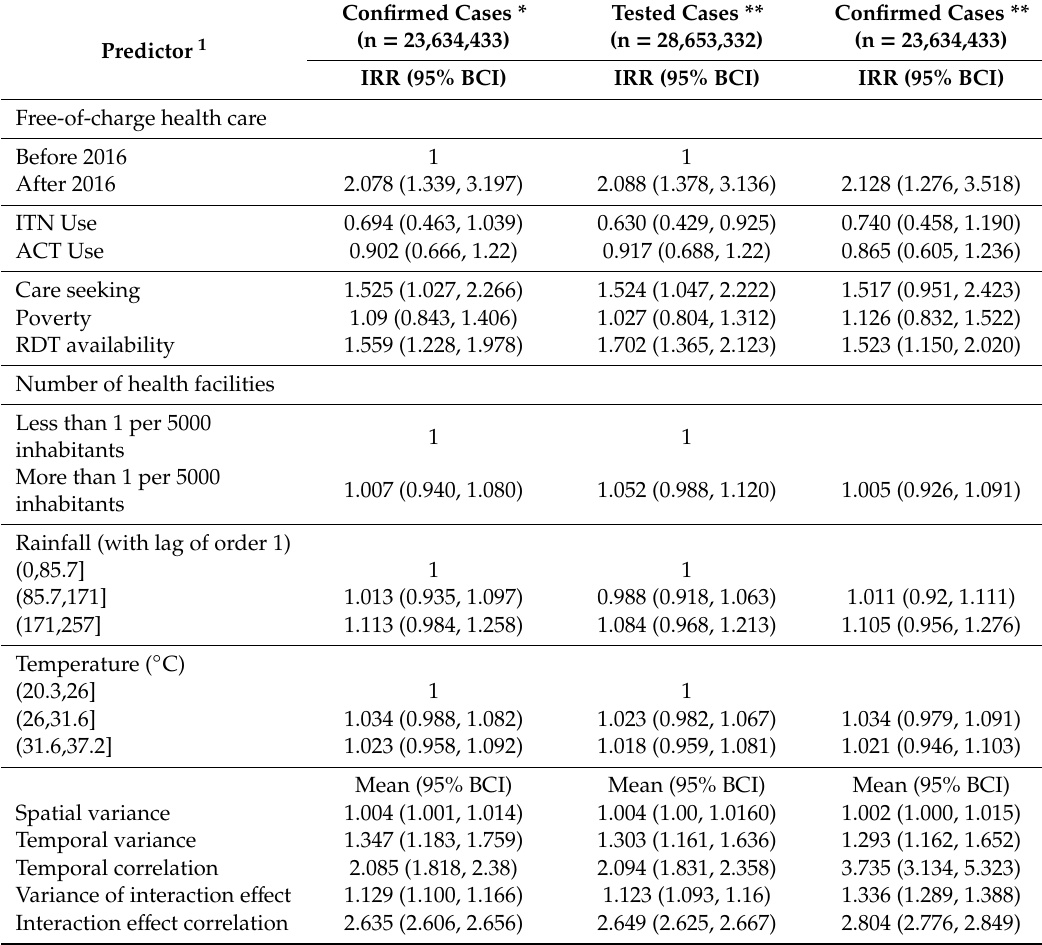
Table 1. E ff ect of interventions on malaria reported cases incidence estimated from Bayesian spatio-temporal models adjusted for socio-economic and climatic